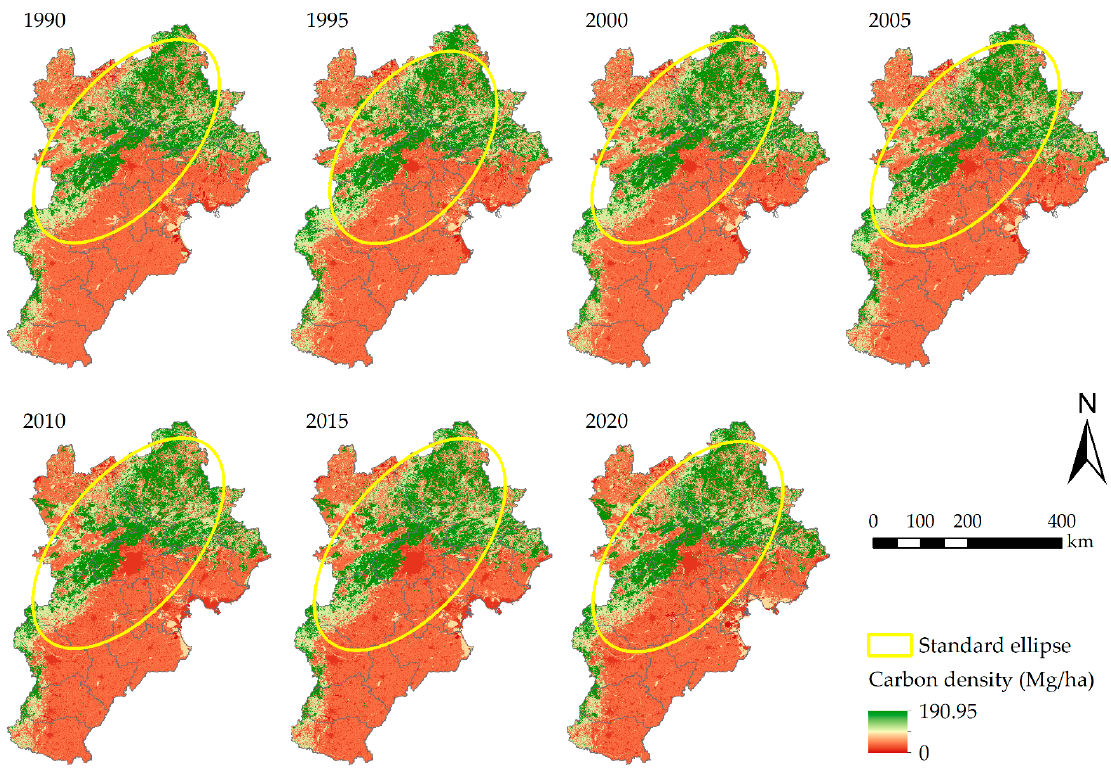
Figure 5. The carbon storage distribution from 1990 to 2020.